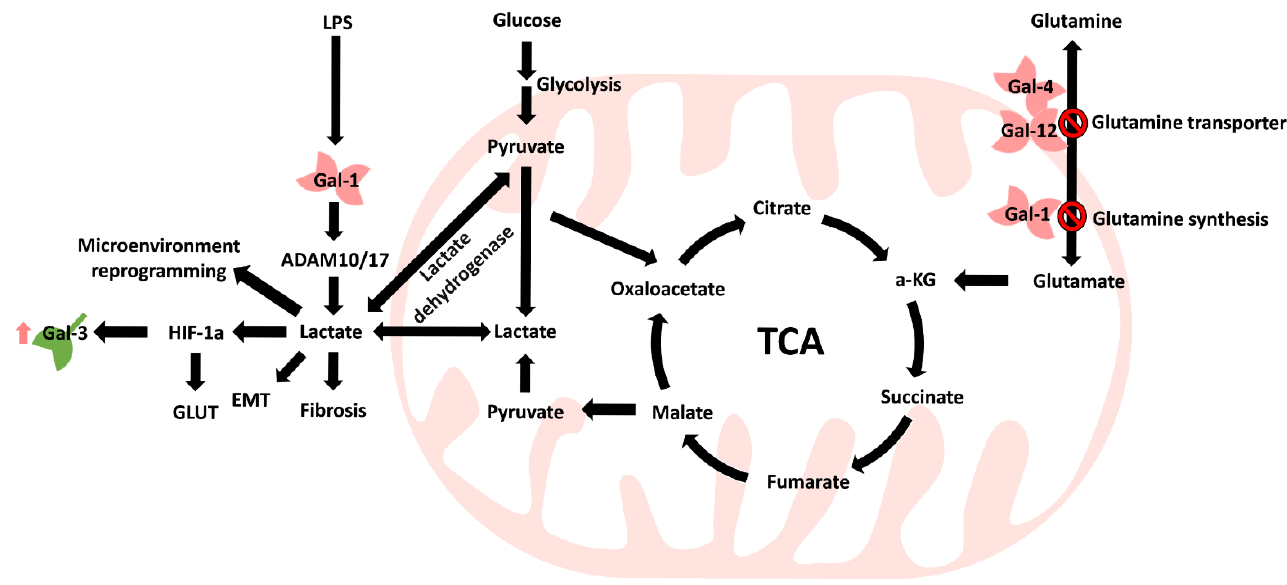
Figure 5. Galectin family involvement in mitochondrial metabolism reprogramming. Gal expression accompanies both metabolism and microenvironment reprogramming, which can be recognized in several diseases, including tumor progression. ↑ Means increase.